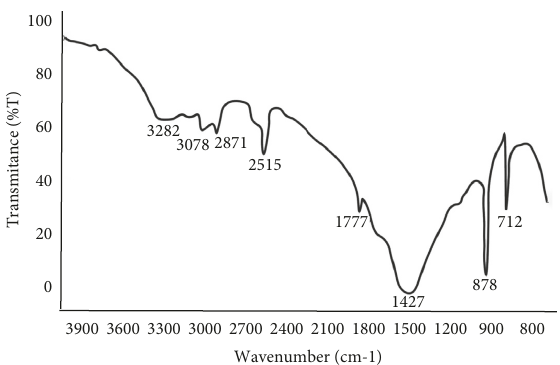
Figure 1: FTIR analysis for the eggshell particle of less than 50 μ m.